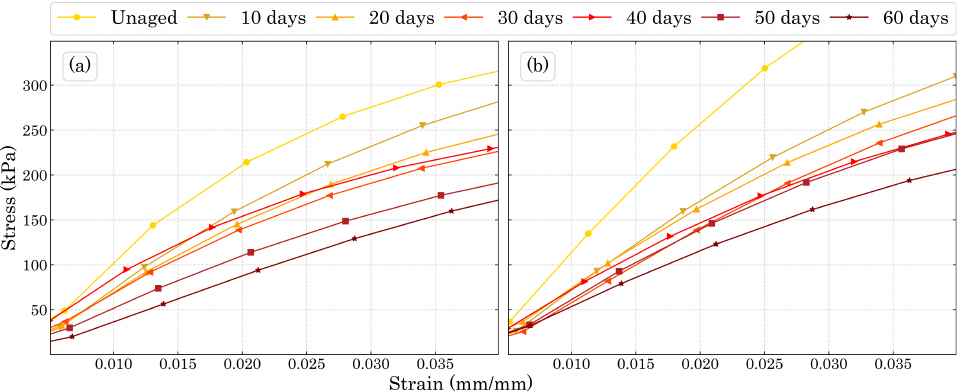
Figure 9. Initial compression stress-strain curves for ( a ) Dir3 and ( b )